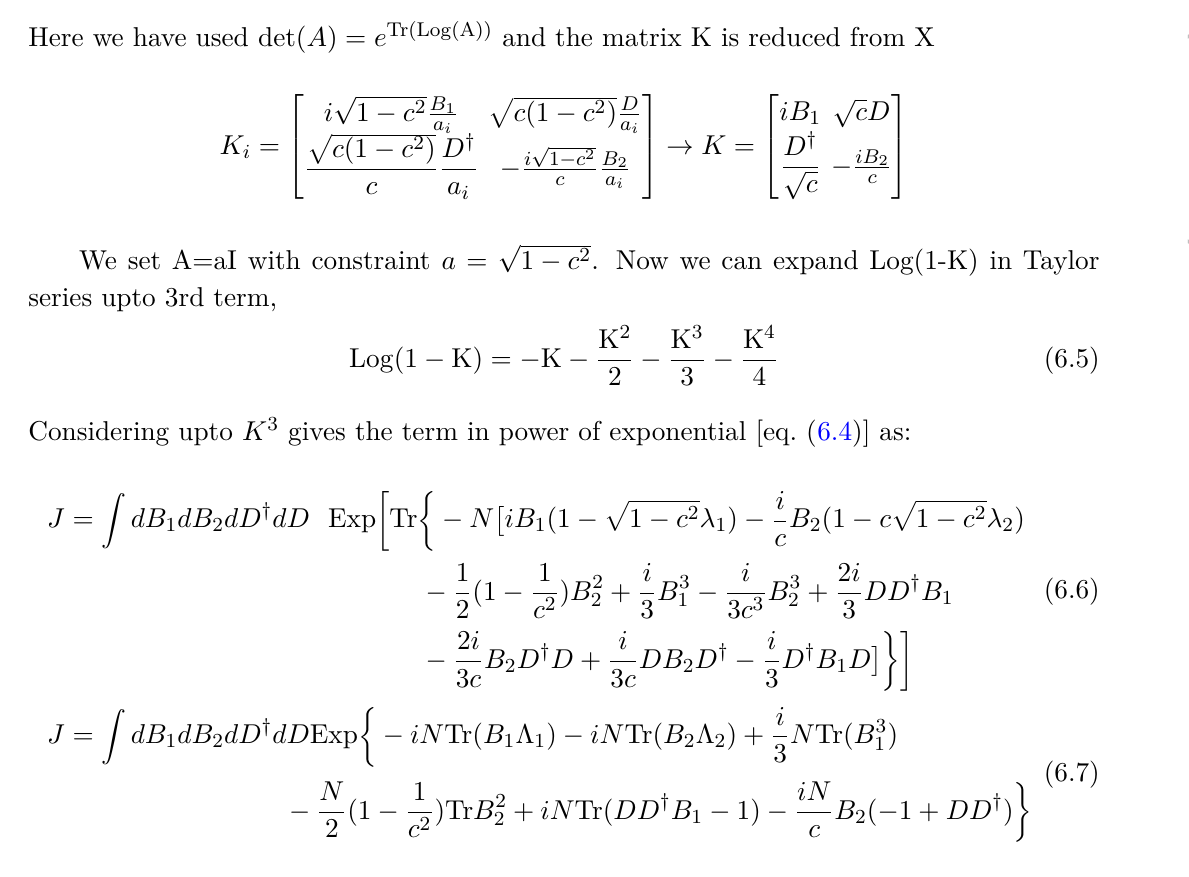
Figure 16 . Ratio of Instanton action from One-point function (eq. (5.11)), from two-point function (eq. (5.16)). Here A inst [ U 0 ( τ )] is the instanton action from one-point function (eq. (5.11)) and A inst [ U 0 ( τ, − τ )] is from two-point function (eq. (5.16)). In large τ limit the ratio become constant which supports the predicted proportional